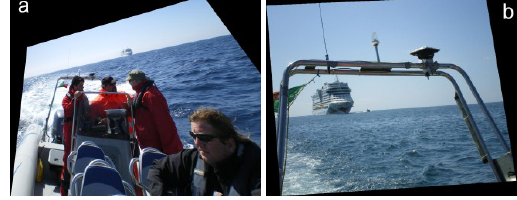
Figure 17. Rectified photos taken aboard the escort craft during the cruise (a) and afterpilotboarding (b) used toestimatethe heel influence on the antenna